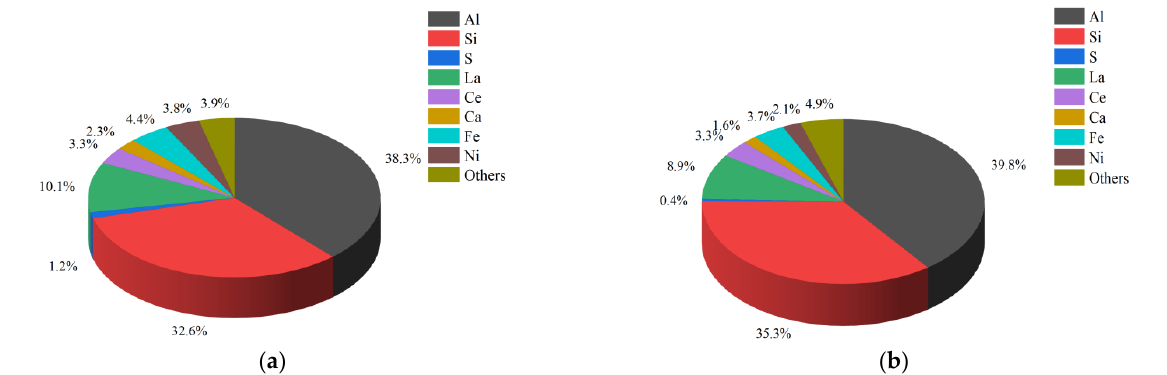
Figure 5. Relative proportions of main elements. ( a ) Before modification; ( b ) after modification.